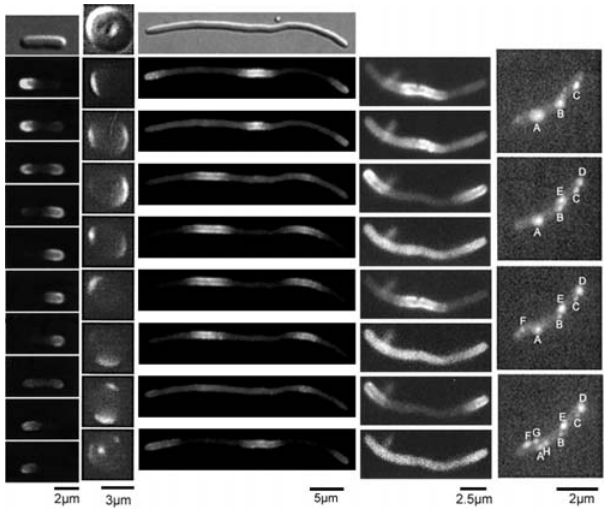
Figure 1. Time-Lapse Microscopy Images of GFP-Tagged MinD in Four Different E. coli Strains From top to bottom: time evolution. From left to right: wt, spherical rodA (cid:1) , filamentous ftsZ (cid:1) (long), filamentous ftsZ (cid:1) (short), PE (cid:1) E. coli . Images are reproduced from (left to right) from the following references: [21], [25], [27], [15], and [26]. DOI: 10.1371/journal.pcbi.0020080.g001